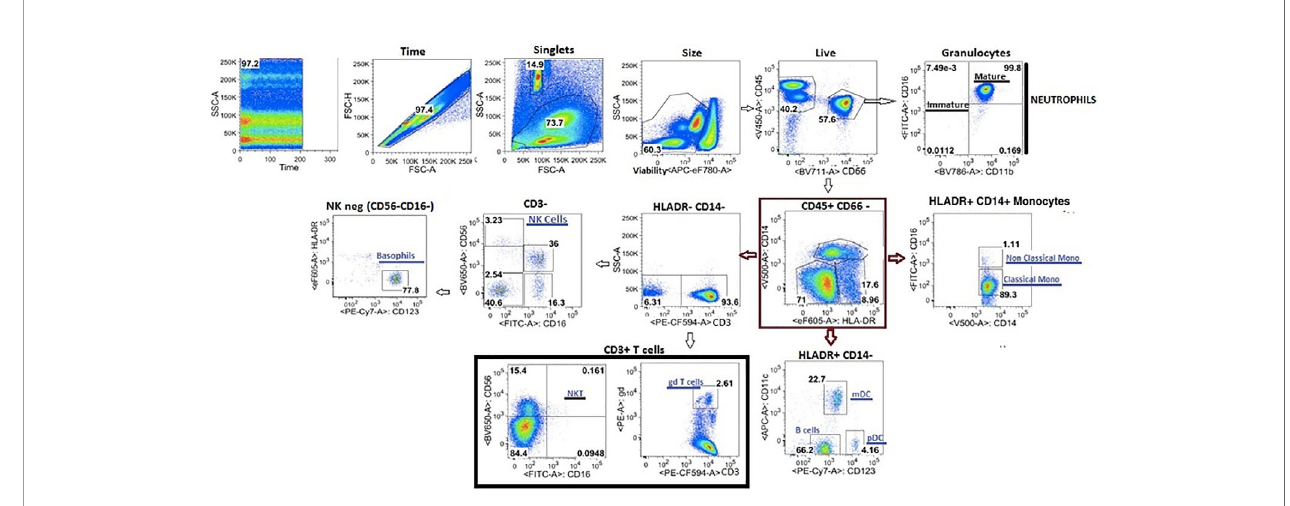
FIGURE 4 | Flow cytometry gating strategy of immune cells in whole